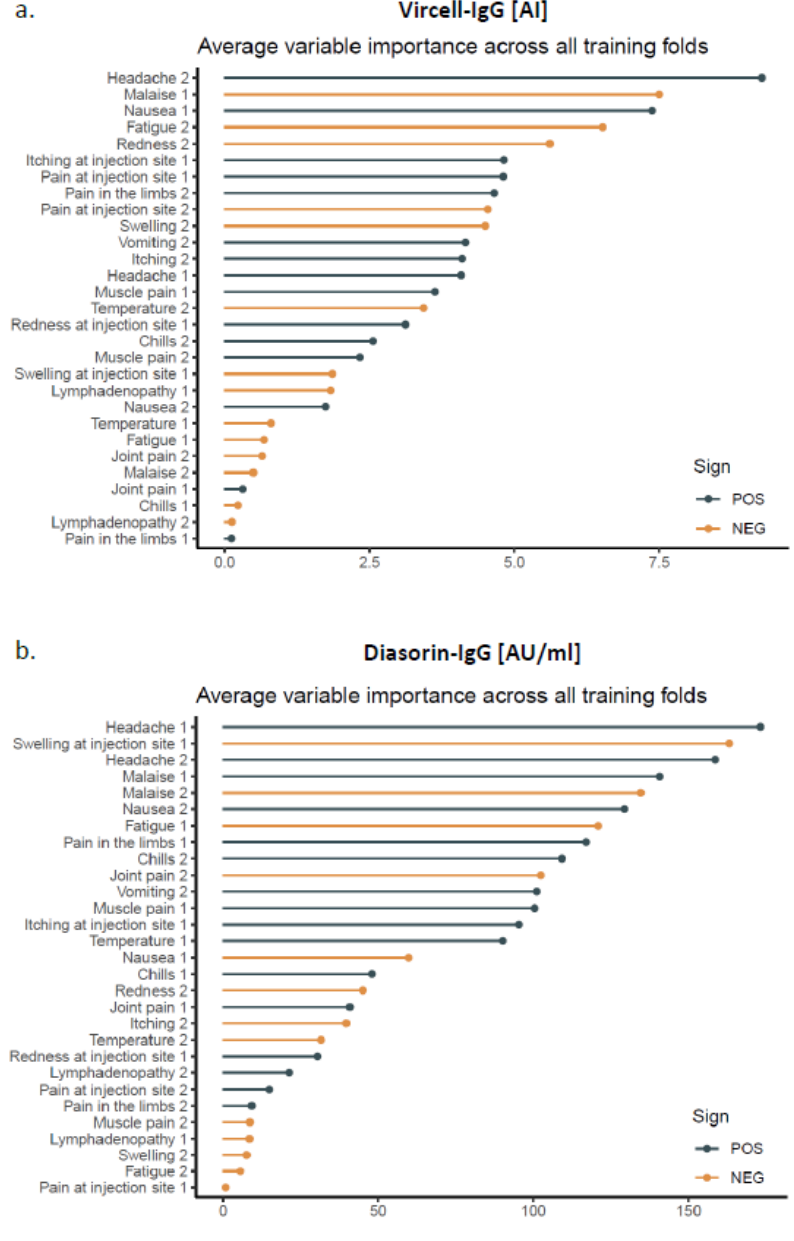
Figure 3. Average variable importance for the prediction of antibody levels measured with ( a ) Vircell-IgG and ( b ) DiaSorin-IgG from the adverse effects. Lines in grey or lines in orange represent adverse effects that show a positive or negative correlation with the antibody levels, respectively. The number behind the adverse effects refers to the time point of the occurrence (1 = after prime vaccination and 2 = after boost vaccination).